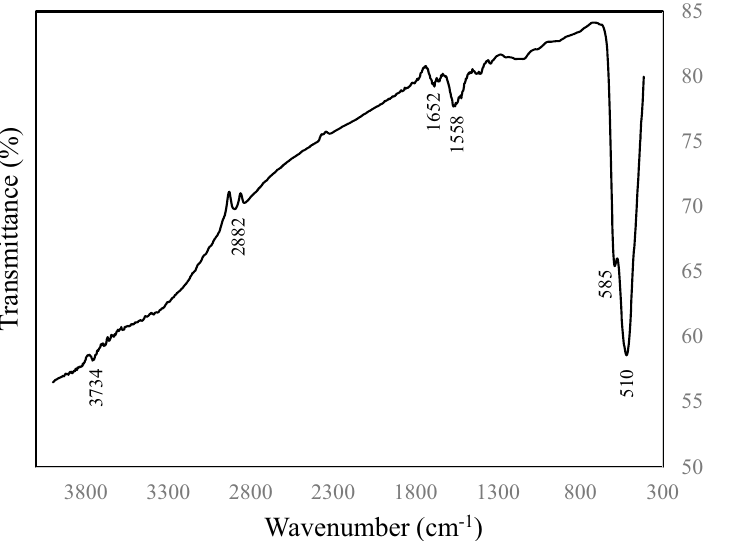
Figure 6. FTIR spectrum of the synthesized rGO–CuO–NHS.